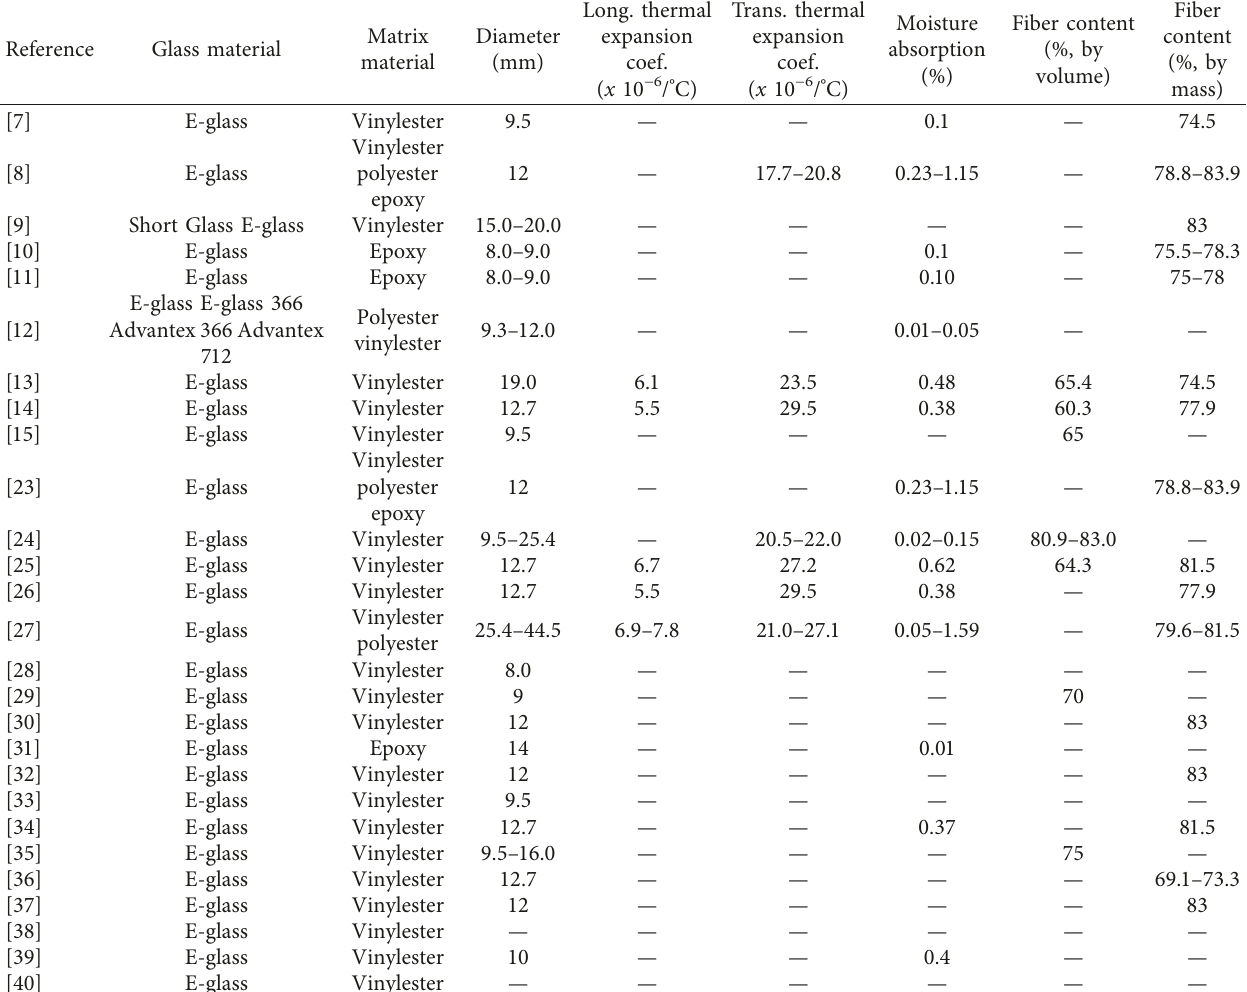
Table 2: Physical properties of GFRP reinforcing